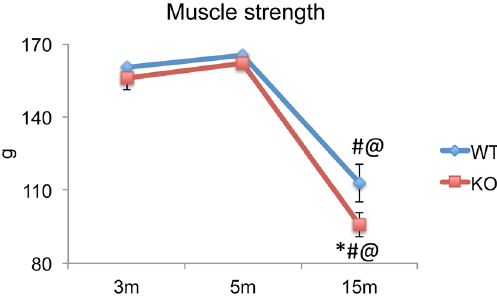
Figure 2. Forelimb grip test during the aging process in female Fgf2KO mice. The same mice were subjected to the grip strength test at 3, 5 and 15 months of age. Measurements were performed 3 times per day for 3 days, and the data were averaged as an individual value. Time course of muscle grip force analyzed by the Two- way repeated measure ANOVA, along with Tukey’s multiple comparison test showed that no grip strength differences were observed between 3 and 5 m WT mice, however there was a significant reduction between 3 m WT and 15 m WT as well as 5 m WT and 15 m WT. There were no significant differences between 3 and 5 m WT and 3 m and 5 m Fgf2KO mice. There were no significant differences between 3 and 5 m Fgf2KO mice, however there was a significant reduction between 3 m Fgf2KO and 15 m Fgf2KO as well as 5 m Fgf2KO and corresponding 3 m p <